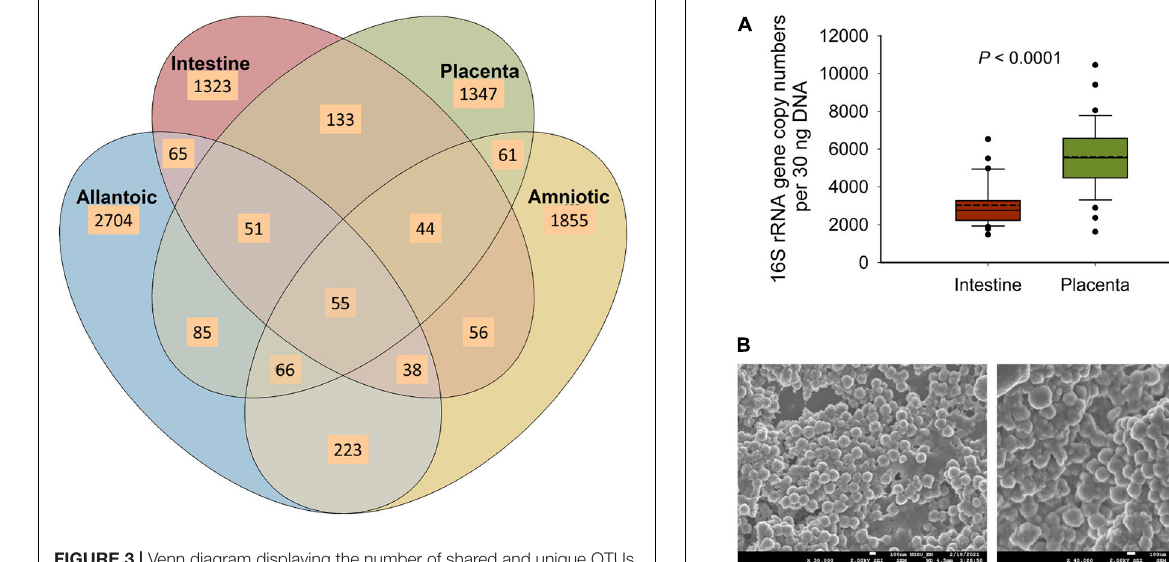
FIGURE 3 | Venn diagram displaying the number of shared and unique OTUs among the allantoic and amniotic fluid and intestinal and placental microbiota in 83-day-old calf fetuses.